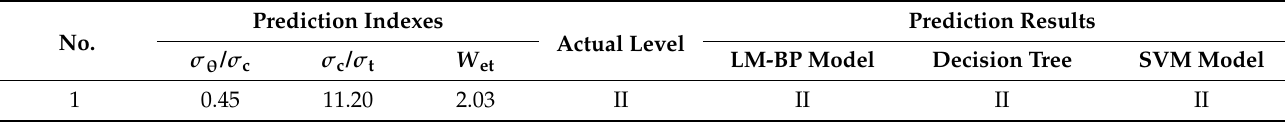
Table 6. Rockburst data and prediction results of Maluping mine.